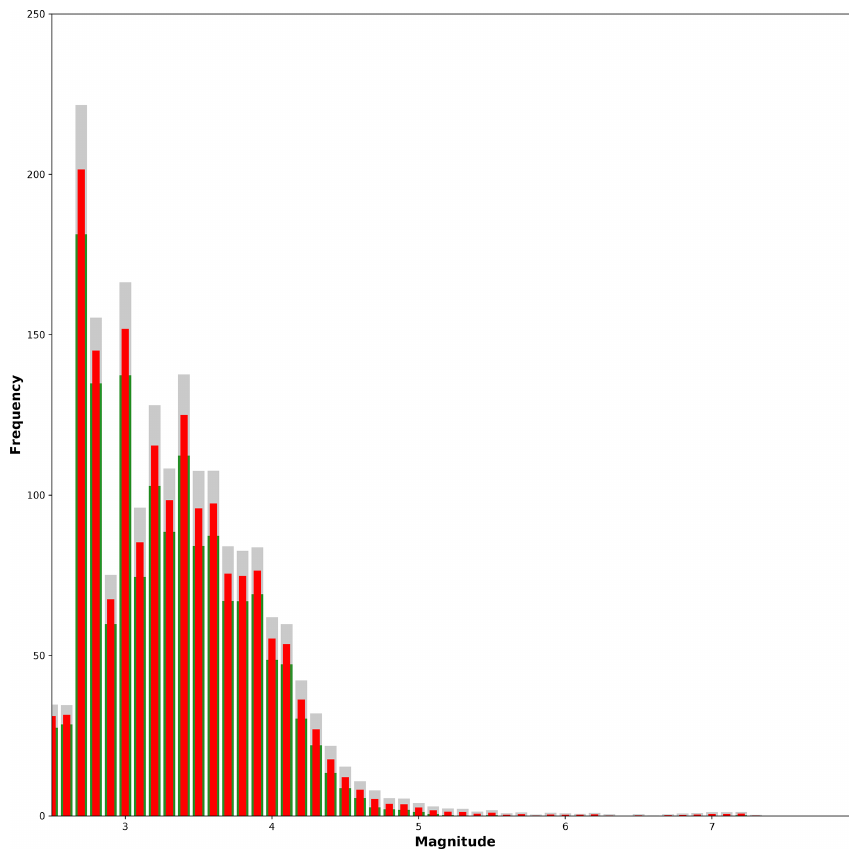
Figure 9. Magnitude histogram computed from the aggregated synthetic seismicity using the Ramírez-Gaytán et al. (2014) relation. Gray and green bars indicate the standard deviation from the statistical analysis, blue bars the sum of the mean values per magnitude